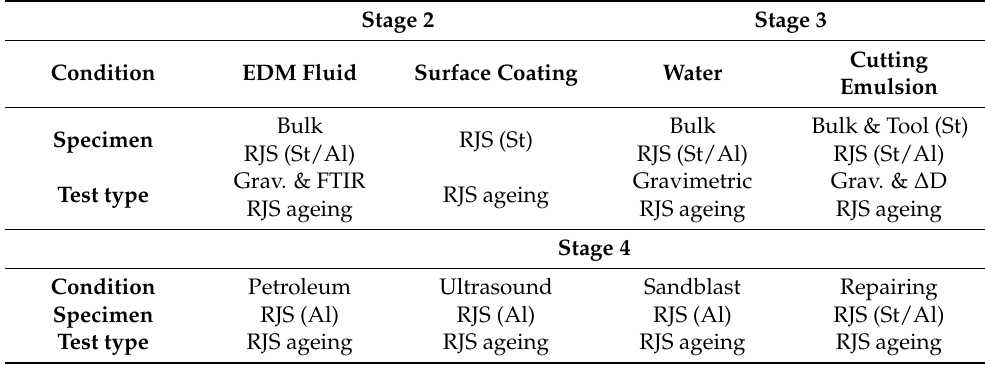
Table 2. Testing plan summary for the life-cycle analysis of the tools. Tool body materials defined as steel (St) and aluminium (Al).